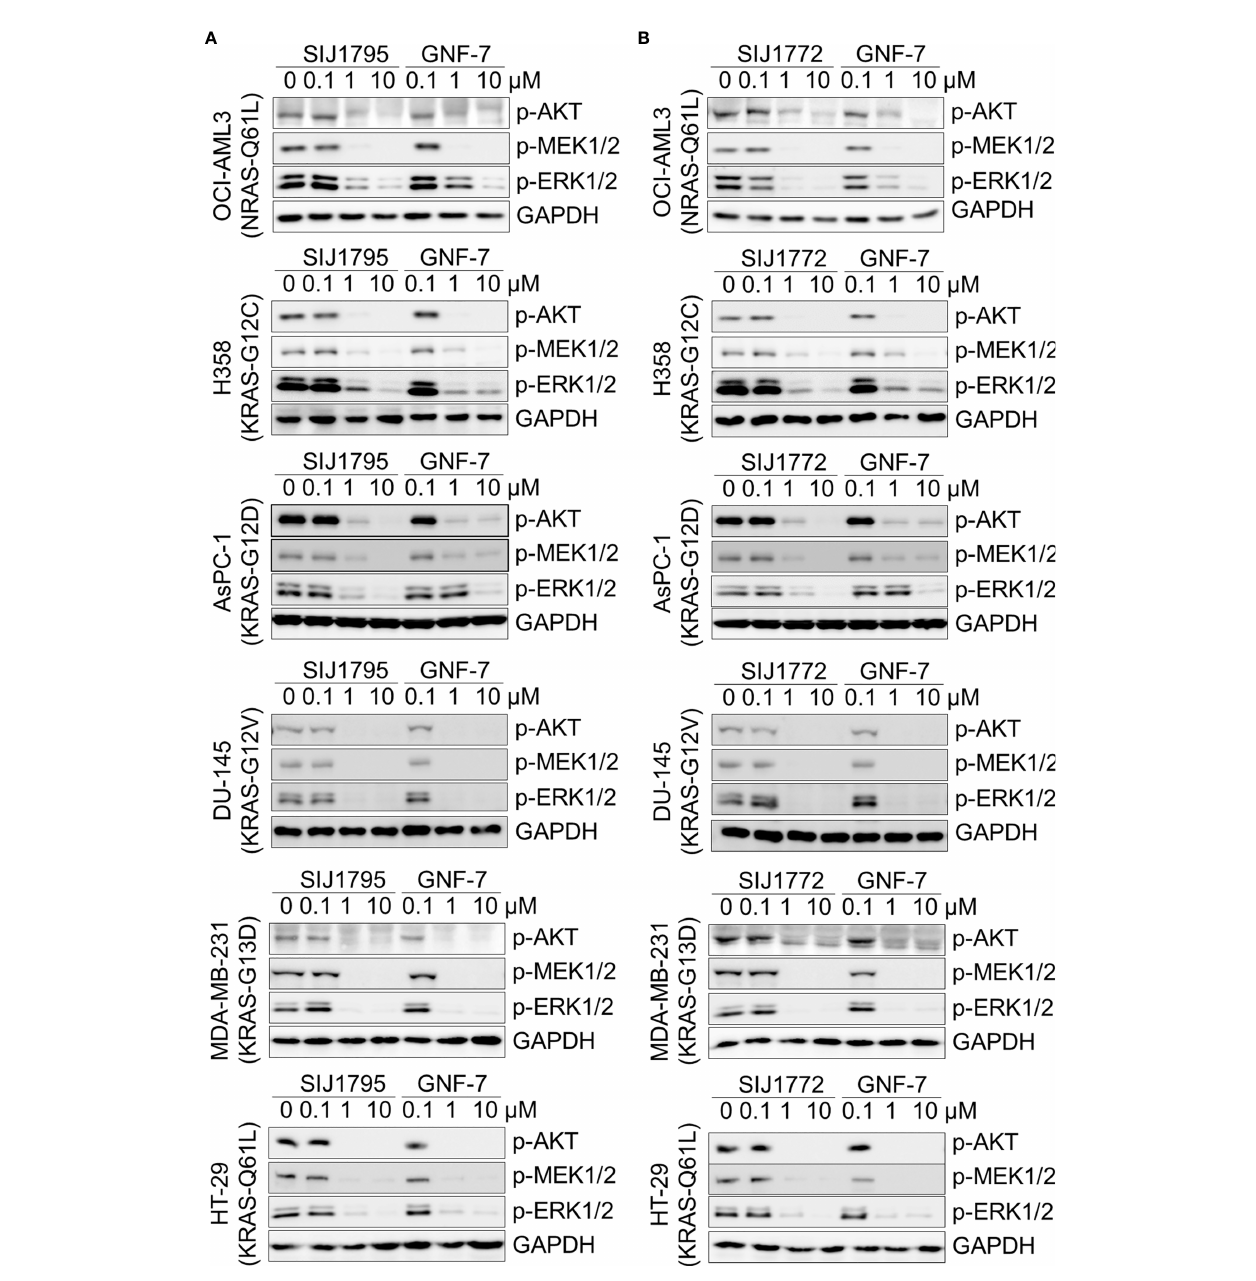
FIGURE 2 | The effect of (A) SIJ1795 and (B) SIJ1772 on mtRAS downstream signaling pathways (MAPK, PI3K/AKT signaling) in cancer cells harboring mtRAS. Cells were treated with 0.1, 1, and 10 m M of SIJ1795, SIJ1772, and GNF-7 for 2 h. Western blot analysis was conducted to evaluate the phospho-AKT, -MEK, -ERK levels. GAPDH was used as the loading